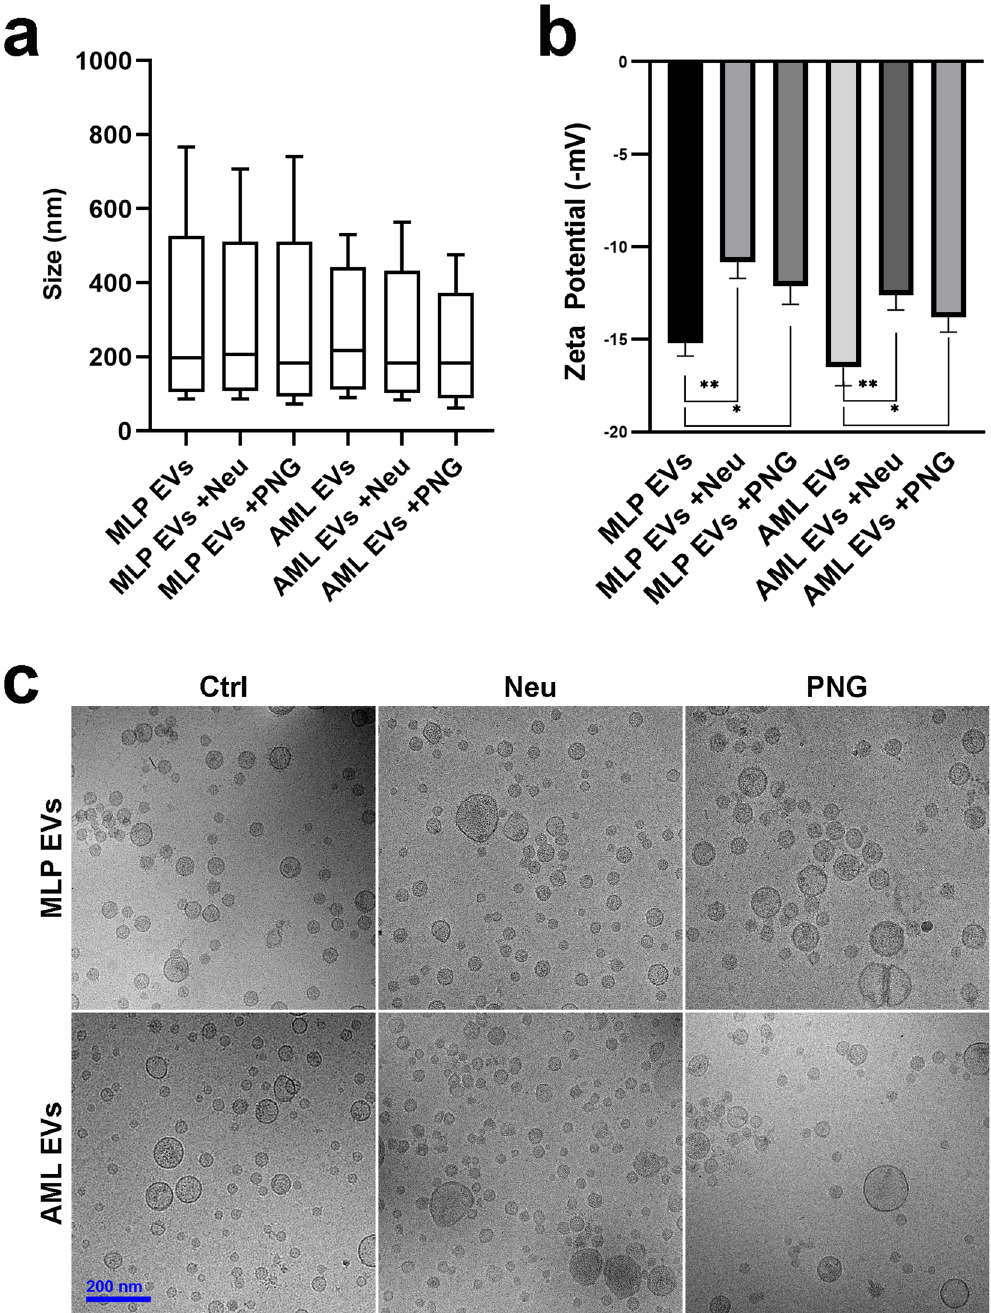
Figure 4. Physical characterisation of EV models. ( a ) Nanoparticle tracking analysis (NTA) of vesicle diameter sizes. Box plots show D10, mean and D90 parameters whilst whiskers exhibit minimum and maximum particle diameters observed. ( b ) Zeta potential determination of particle charges. Significance is calculated by Student’s t test from technical replicates ( * p < 0.05, ** p < 0.01, error bars represent S.D.). ( c ) Cryo-electron microscopy (cryo-EM)